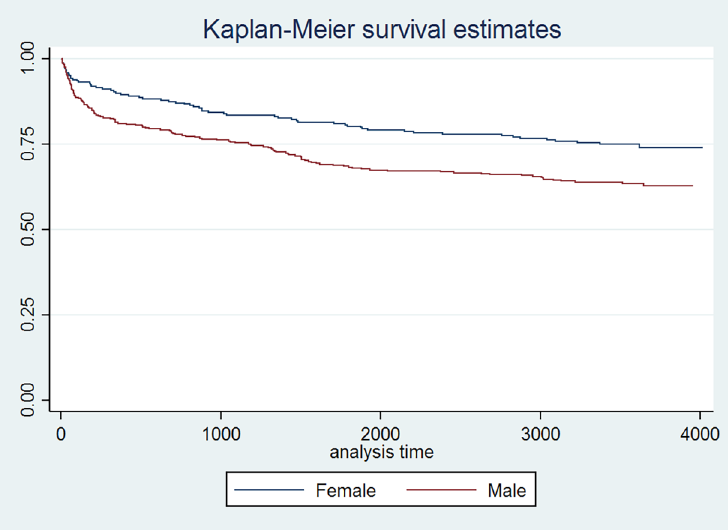
Fig 1. Survival curve by gender for HIV patients in an MSF follow-up program in southern